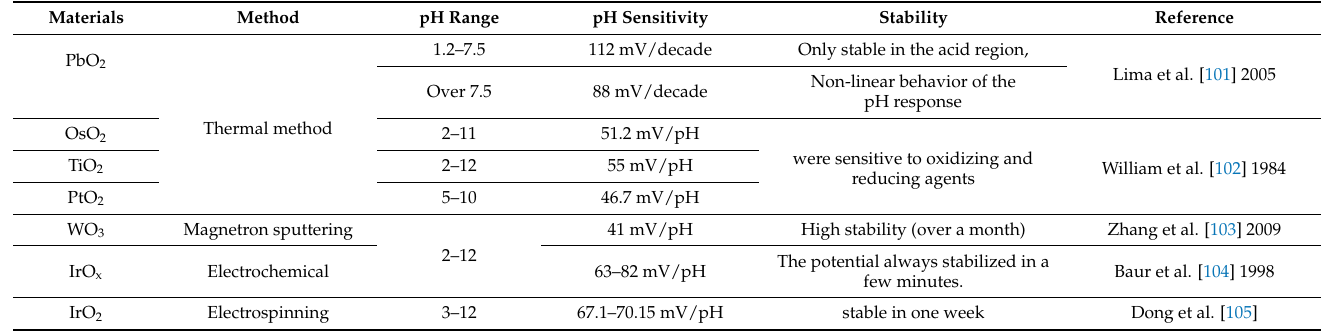
Table 3. The pH measuring characteristics of metal oxide-based pH